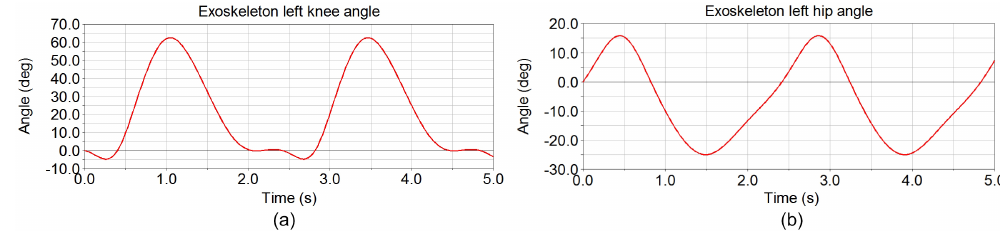
Figure 10. Computed joints angle variation: (a) knee joint; (b) hip joint.